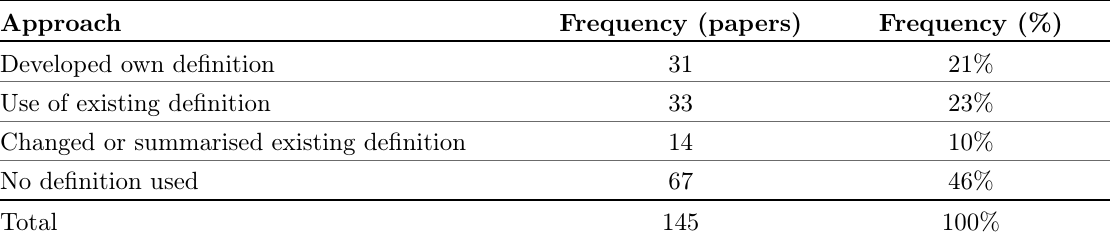
Table 5. Approaches to definition of mobile